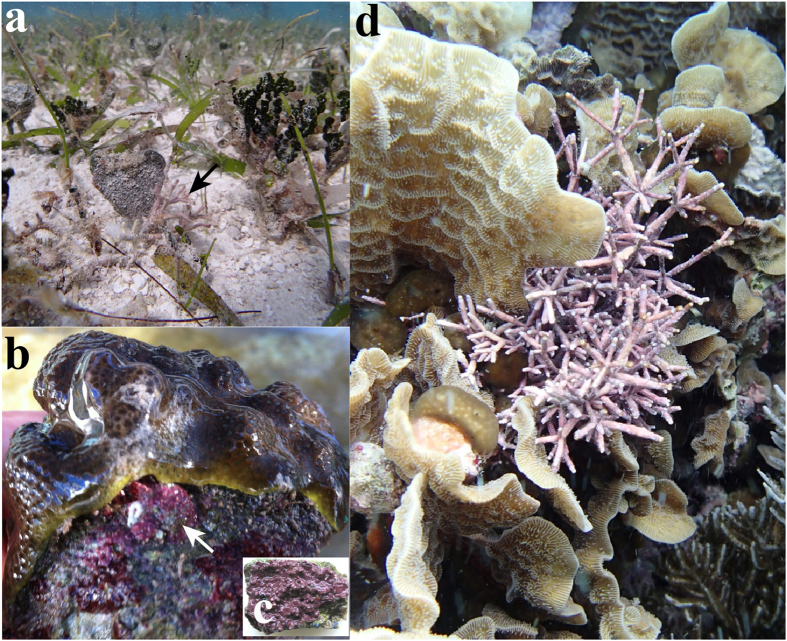
Images of the three coralline species (Rhodophyta) characterized in this study in their natural habitats.(a) Rhodolith (see arrow) belonging to the genus Neogoniolithon sp. collected at a depth of 3 m on sand sediments within sparse beds of the seagrass Thalassia testudinum. (b) The crustose coralline alga (CCA) belonging to the genus Lithothamnion sp. (see arrow) grows on the sides of/underneath Orbicella faveolata/annularis coral colonies at variable depths within the coral community but under very low light conditions. (c) Close-up of a CCA specimen used for the physiological characterization that was collected below an Orbicella faveolata skeleton. (d) The articulated alga Amphiroa tribulus growing within the branches of a colony of the coral Agaricia agarites at a depth of 5 m within the coral community.